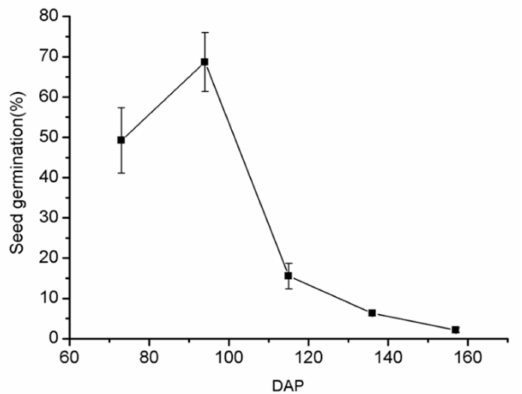
Figure 2. Asymbiotic seed germination rate at di ff erent developmental stages of P. armeniacum . n = 3; ± SD. Each biological replicate contained seeds collected from 10 capsules collected at the same time interval, germinated in 10 culture flasks. Seeds used for germination rate estimation were harvested at 73 DAP, 94 DAP, 115 DAP, 136 DAP, and 157